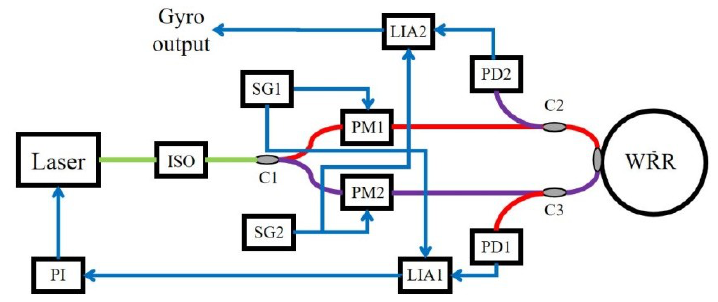
Figure 1. Conceptual diagram of the RIOG based on a phase modulation technique with a reflective